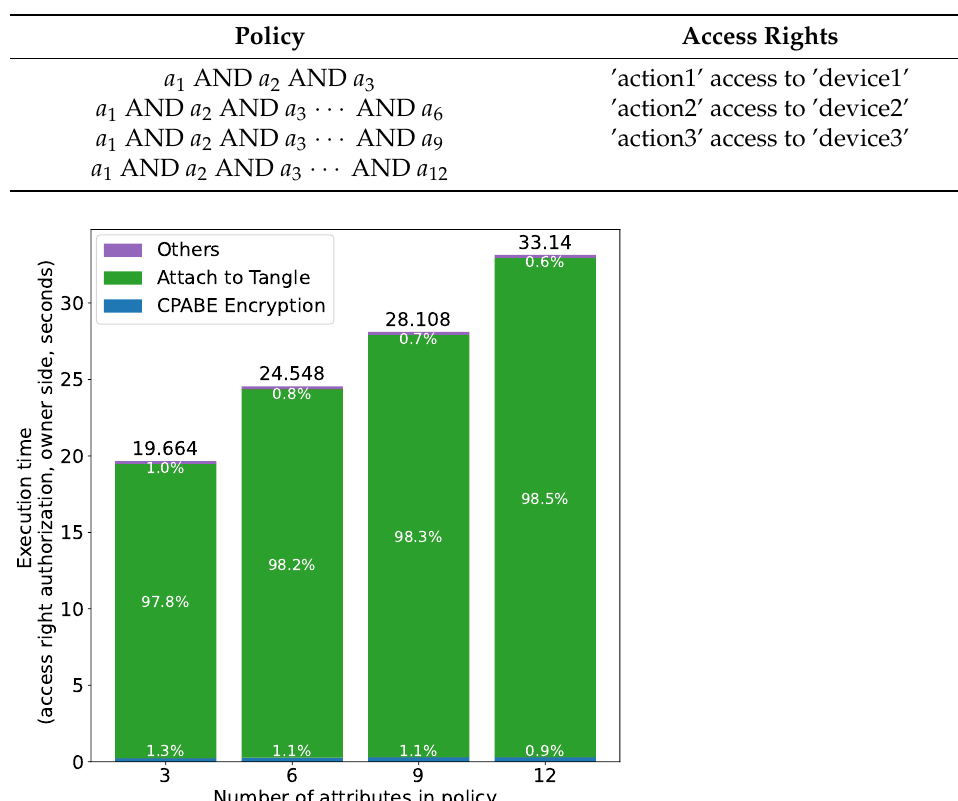
Table 3. Policies and access rights after update ( a i : attribute i ).